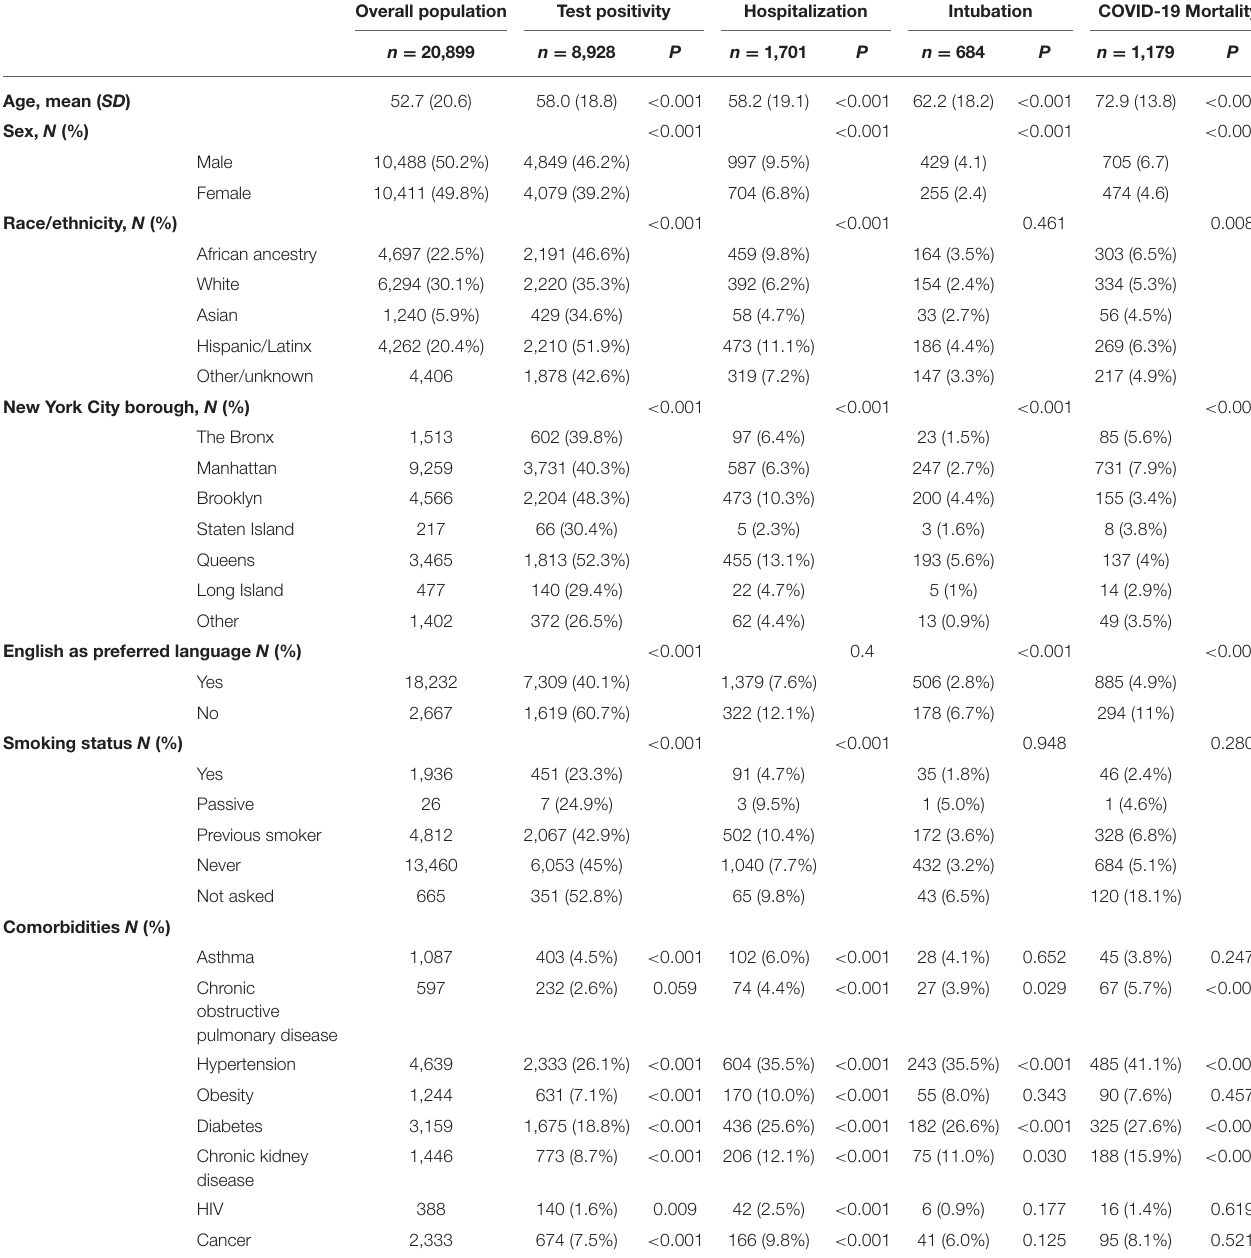
TABLE 1 | Characteristics and bivariate analysis of patients with COVID-19 in this cohort. Overall population Test positivity Hospitalization Intubation COVID-19